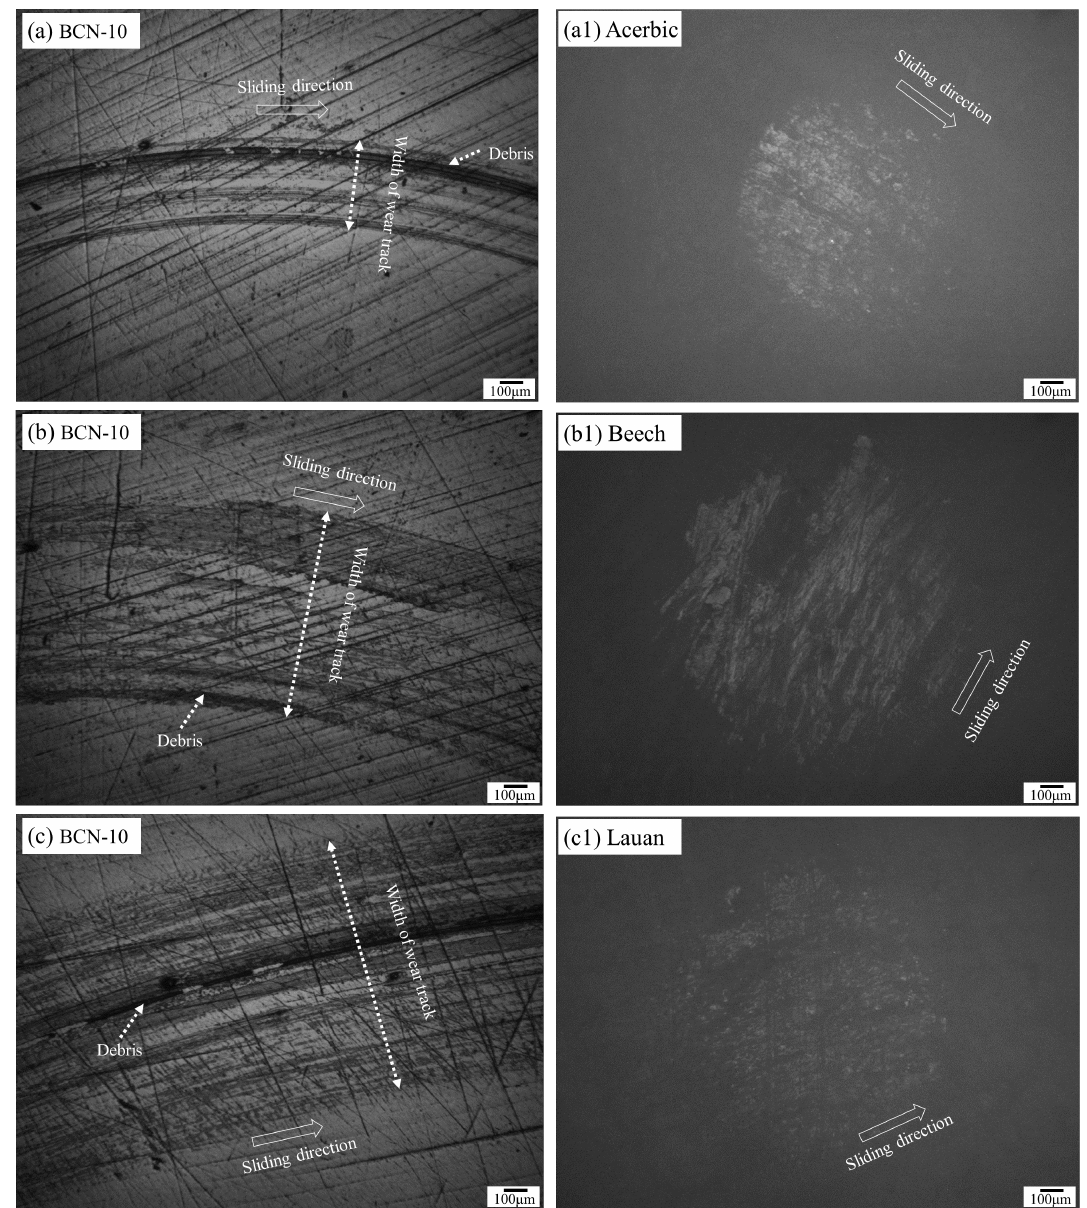
Figure 7: Optical images of wear scars for BCN-10 coating sliding against different wood balls.